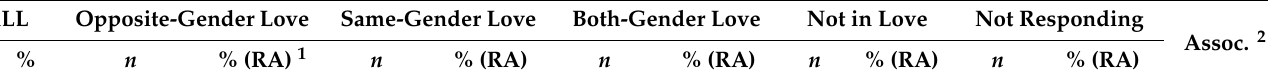
Table 1. Characteristics of the sample, overall and by romantic attraction ( n =